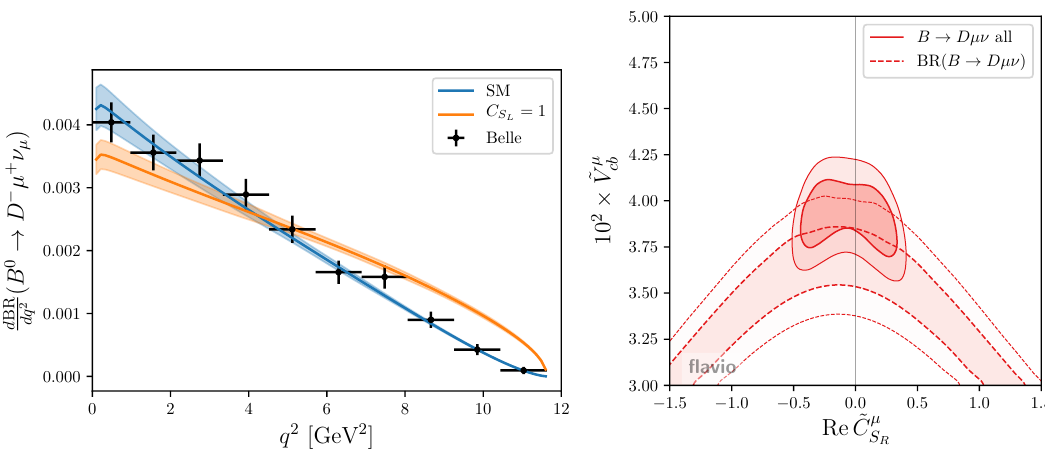
Figure 4 . Left: prediction for the di(cid:11)erential B D(cid:22)(cid:23) branching ratio in the SM (blue band) and ! a scenario with new physics in C S (orange band) vs. the Belle measurement, demonstrating the L di(cid:11)erent endpoint behaviour at zero recoil ( q 2 11 : 6 GeV 2 ). Both scenarios predict the same total (cid:25) B D(cid:22)(cid:23) branching ratio. Right: comparison of the constraint on the scalar coe(cid:14)cient ~ C (cid:22) ! ~ V (cid:22) from the total B D(cid:22)(cid:23) branching ratio measurements only (dashed) and using all B cb ! measurements